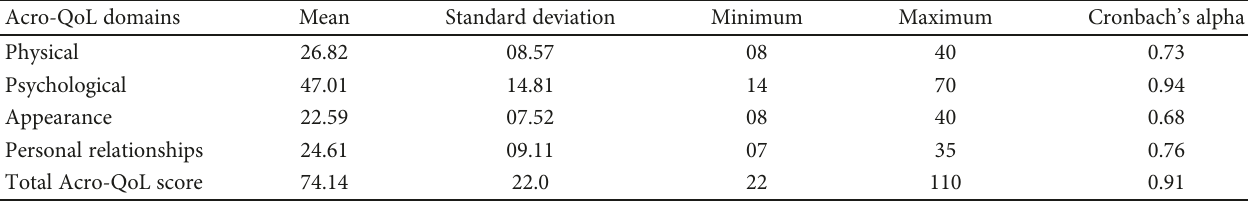
Table 2: Mean scores of the Acro-QoL domains from patients with acromegaly, São Luís, state of Maranhão, Brazil, 2015. Acro-QoL